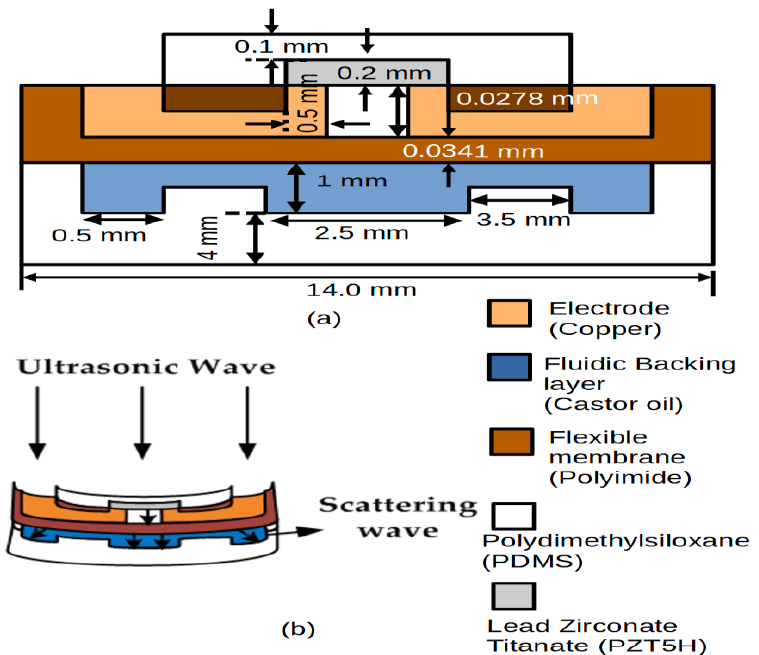
Figure 1. Diagram of the proposed structure of the double flexural membrane sensing device ( a ) and penetration of the ultrasonic wave from the first flexural membrane to second flexural membrane ( b ).